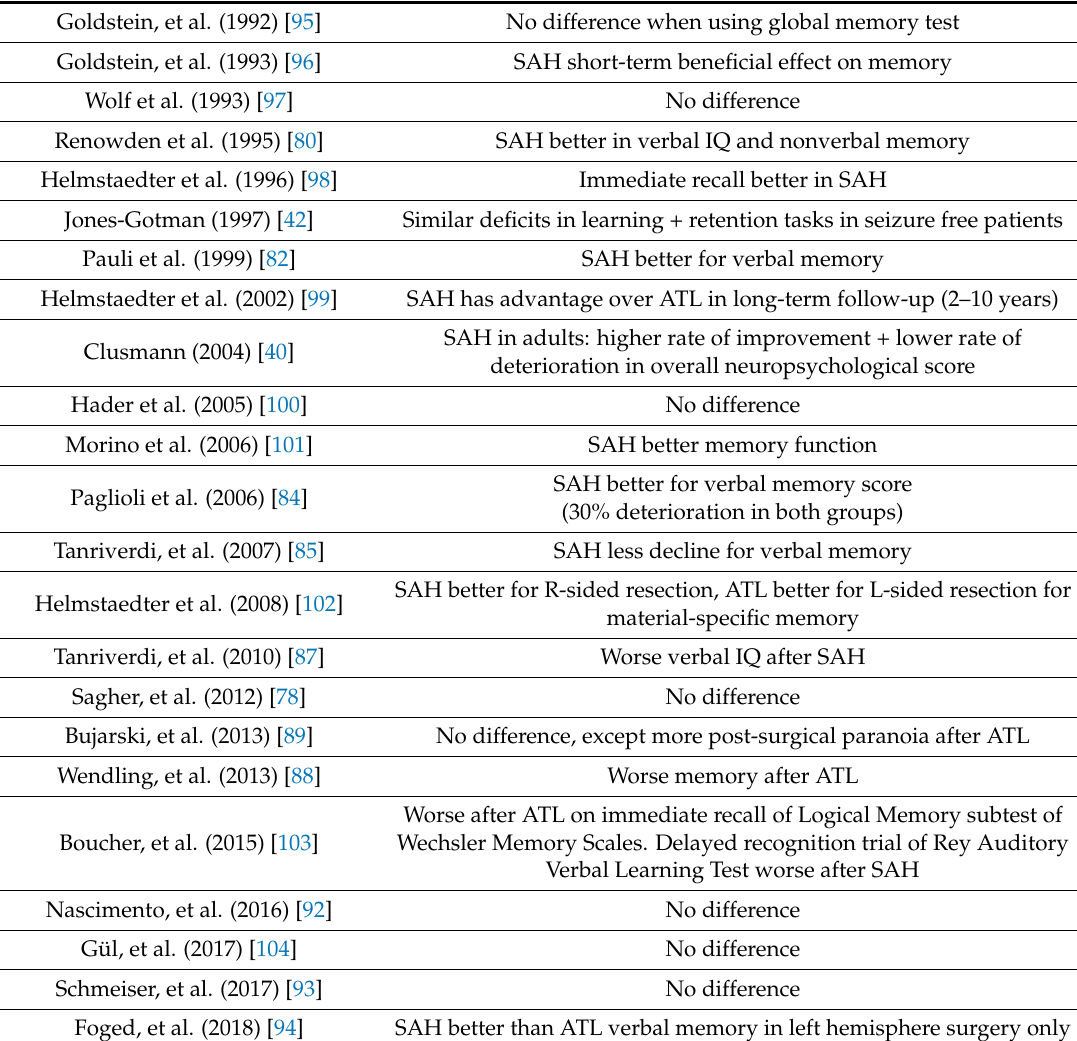
Table 2. Studies comparing temporal lobe surgery of ATL with SAH for neuropsychological